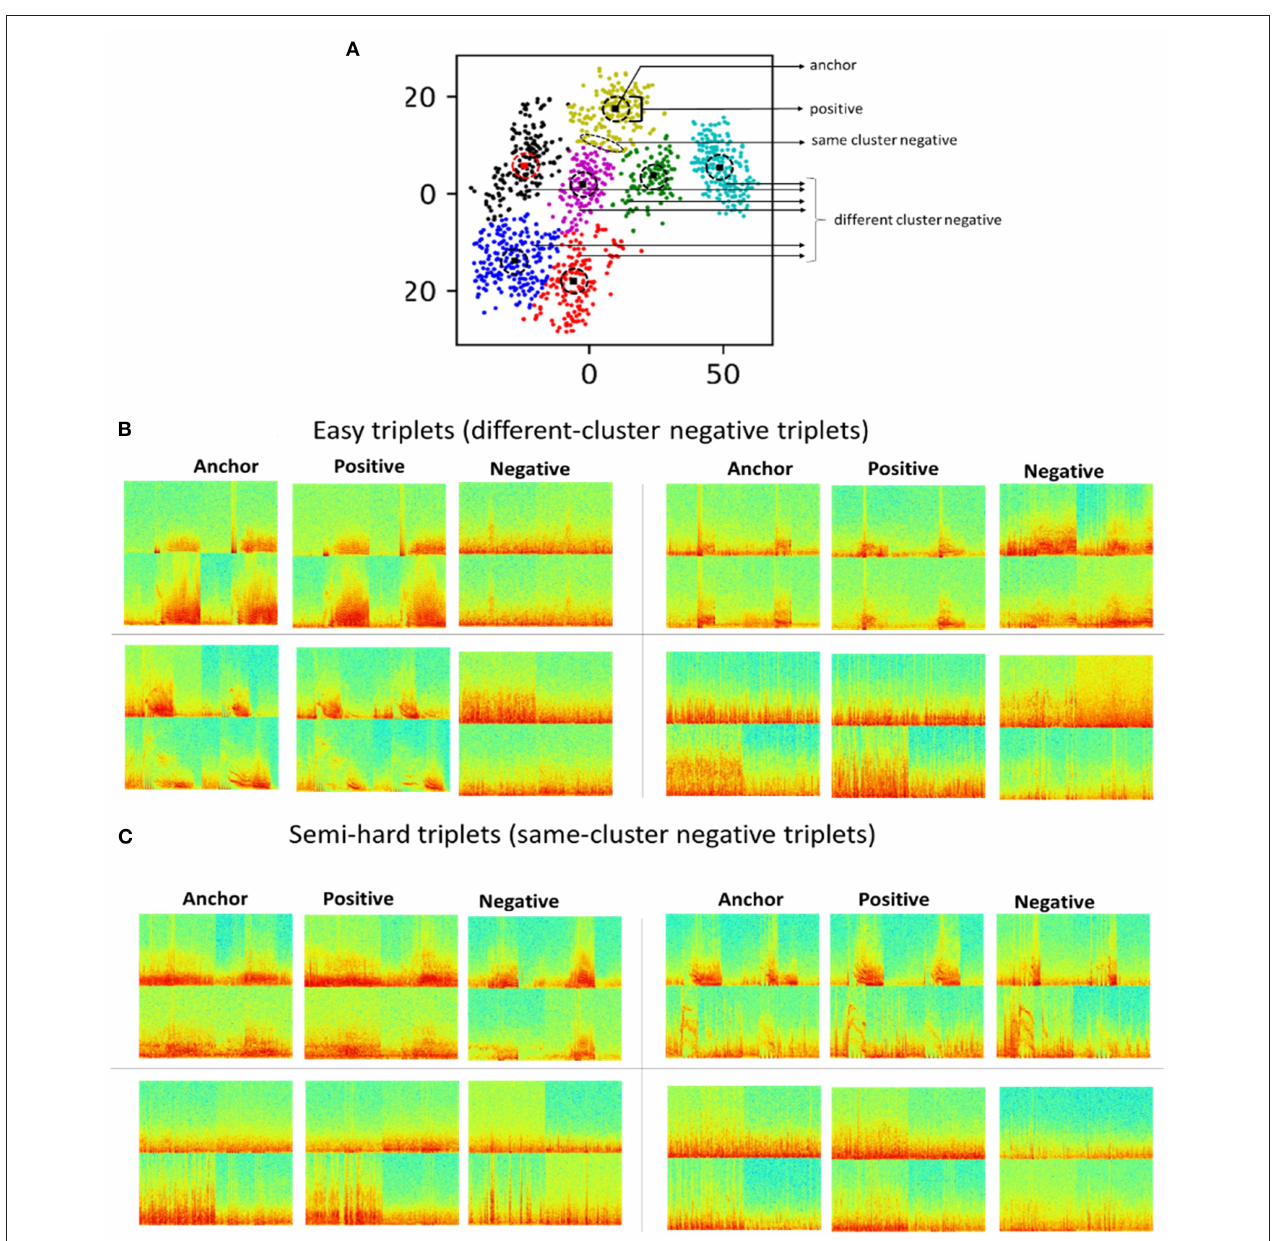
FIGURE 4 | (A) 2D embeddings of all iEEG records from one example patient. All cluster centroid iEEG records were selected as anchors. iEEG records closest to the anchor were selected as positive images. iEEG records further away from the centroid in the same cluster were selected as negative images. iEEG records from other clusters within the same patient were also selected as negative images. (B) Example triplets with negative images from different clusters. (C) Example triplets with negative images from the same